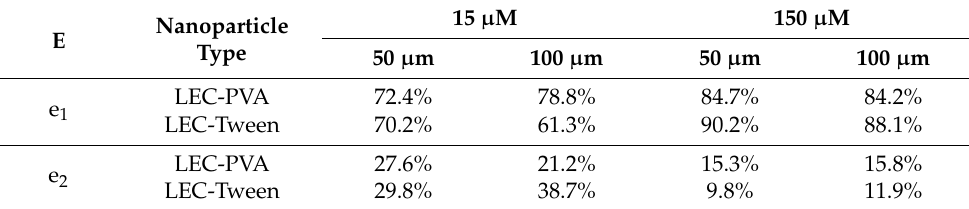
Table 2. Distribution of the physical (e 1 ) and biochemical (e 2 ) of MTX-loaded